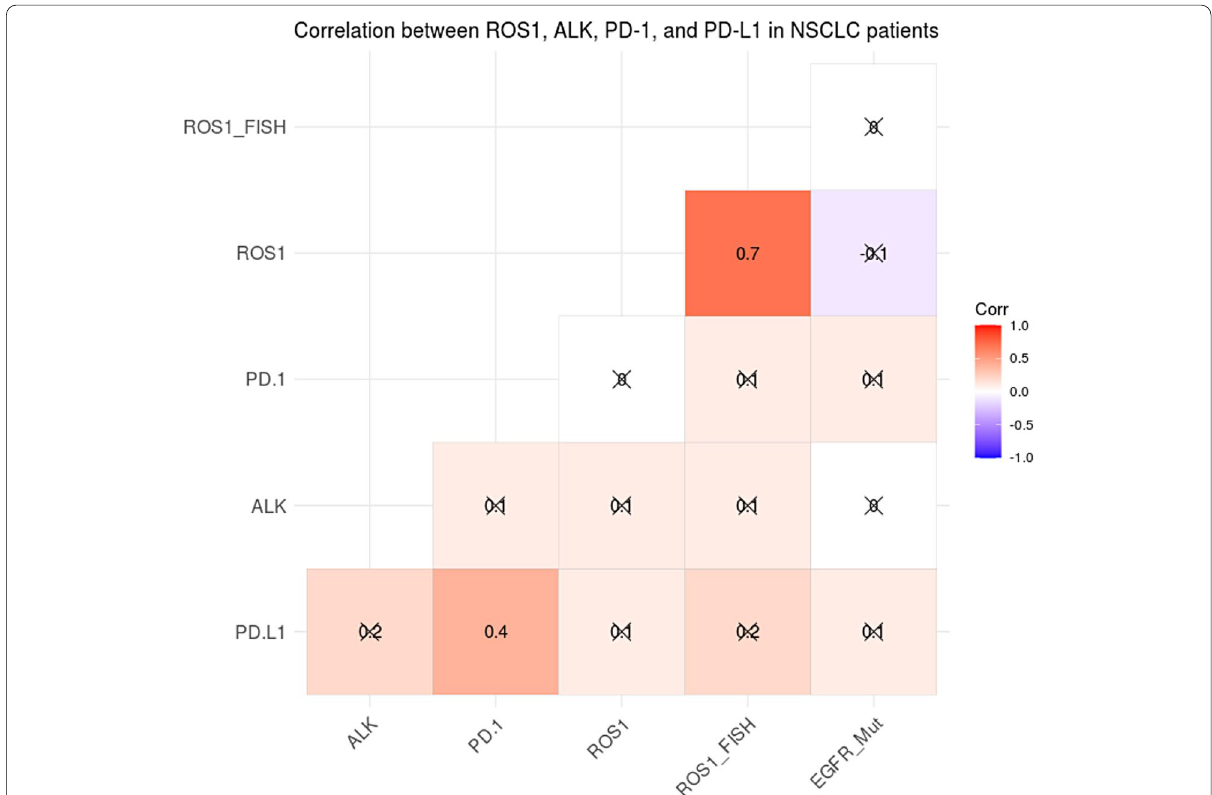
Fig. 5 Correlation matrix showing spearman correlations between ROS1, ALK, and PD‑1/PD‑L1 proteins expression with each other and with ROS1 gene